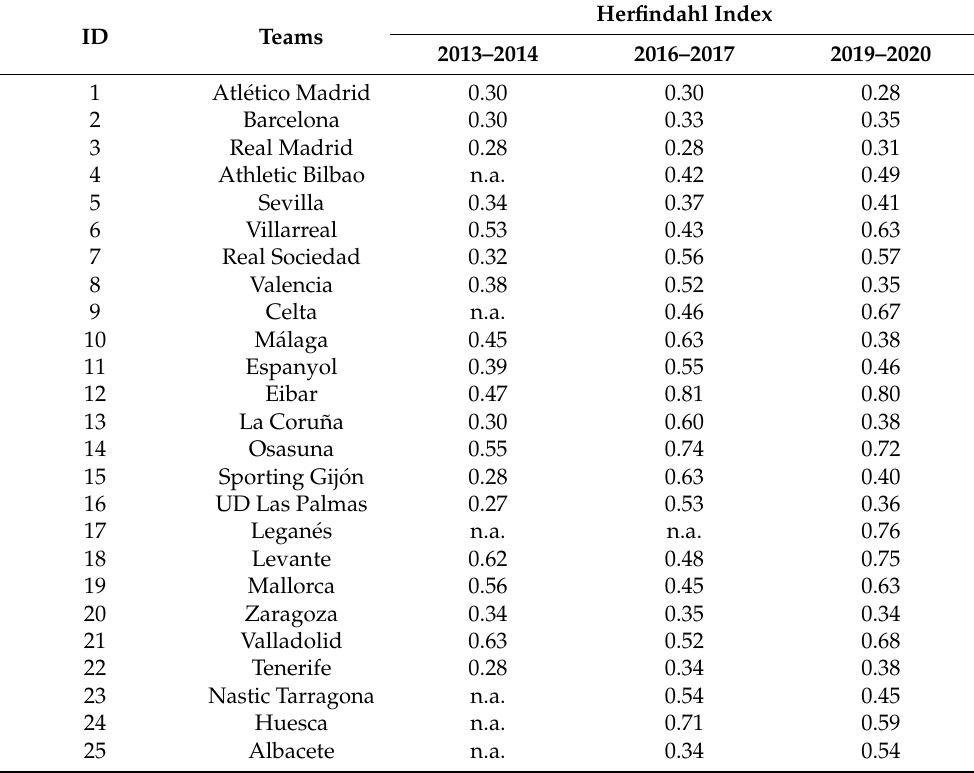
Table 4. Herfindahl